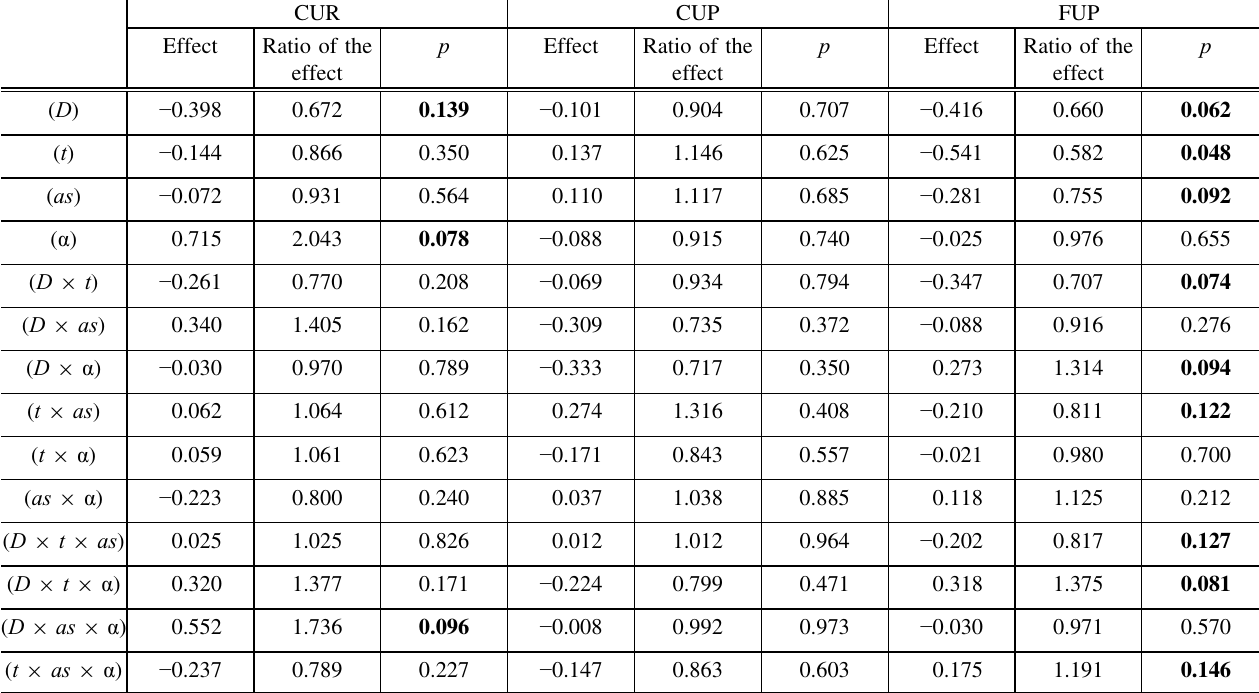
Table 9 Factors and interactions that affect the variability of measured Indirect tensile strength values in the group one of experiments a